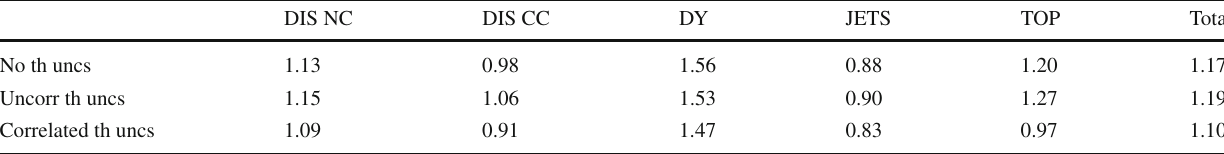
Fig. 7 The experimental χ 2 for each data set, comparing the original result of the NLO fit with no theory uncertainties to the fit with theory uncertainties, and then including the correlated shift in the autopredictions Table 2 The experimental χ 2 per data point for each process, comparing the original result of the NLO fit with no theory uncertainties to the fit with theory uncertainties, and then including the shift in the autopredictions DIS NC DIS CC DY JETS TOP Total No th uncs 1.13 Uncorr th